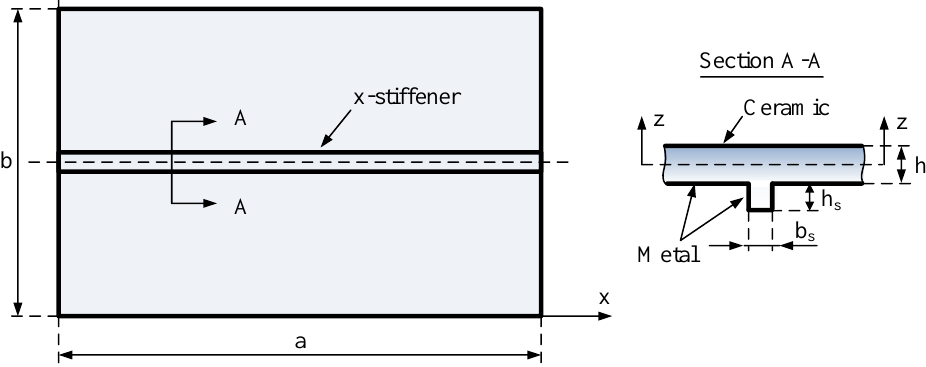
ff ened by an x -direction sti ff